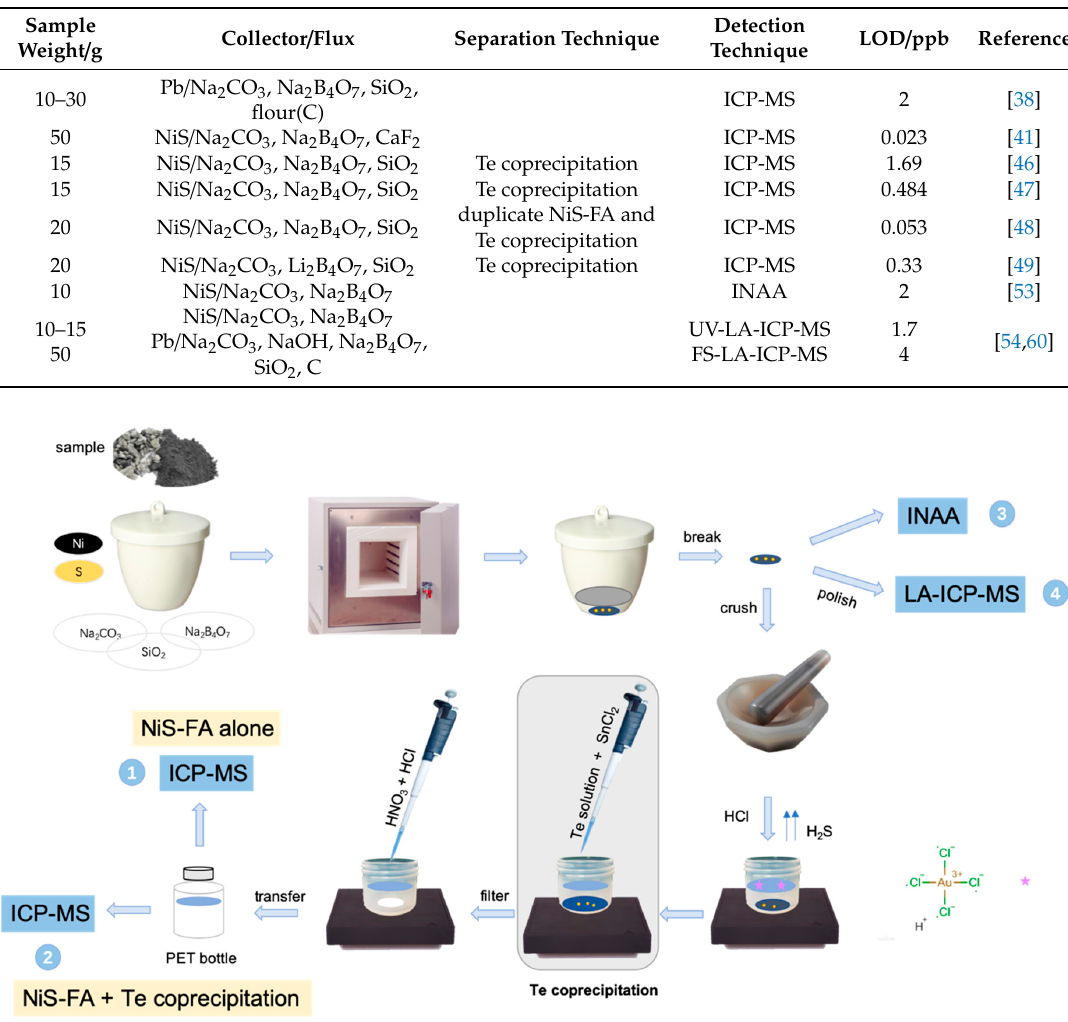
Table 1. A summary of various FA digestion methods.